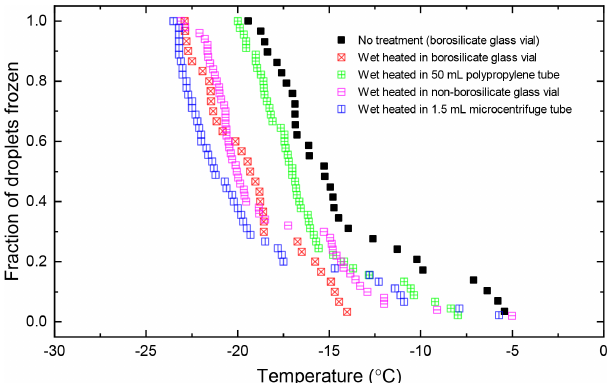
Figure A2. Thermocouple measurements of suspension tempera- ture inside both glass and plastic vessels during the wet heat treat- ment